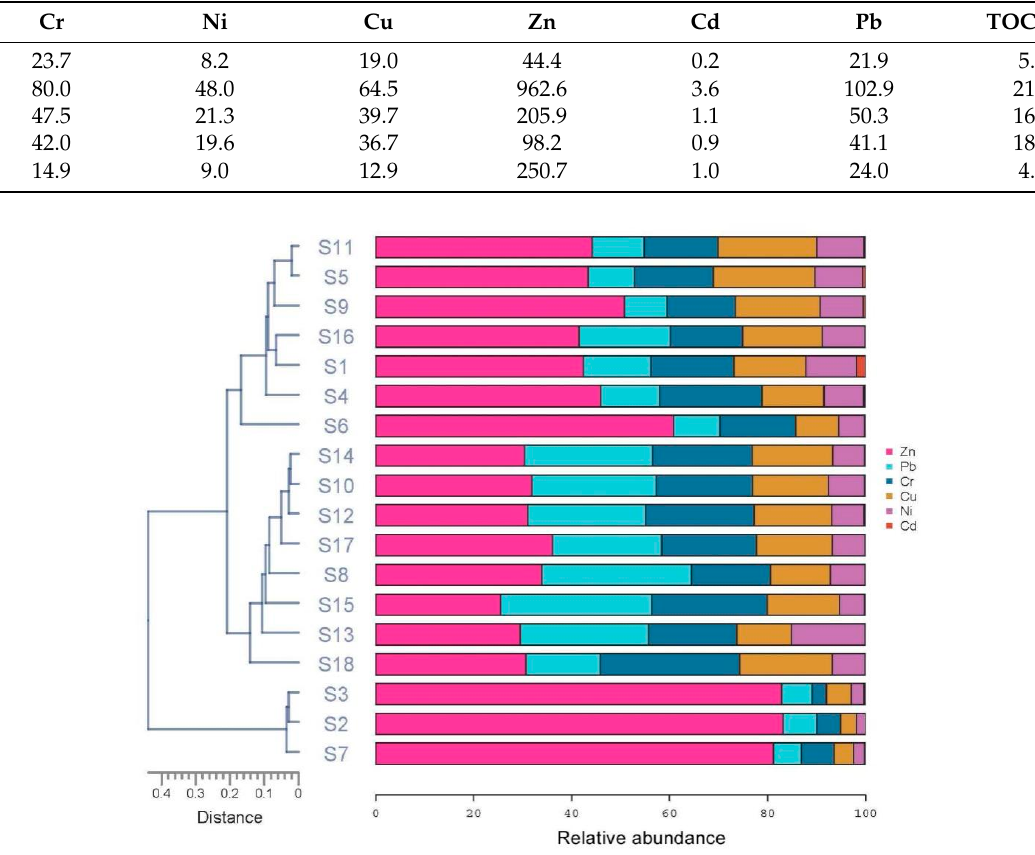
Table 1. Heavy metal concentrations in sediments from Shantou Bay (mg/kg).